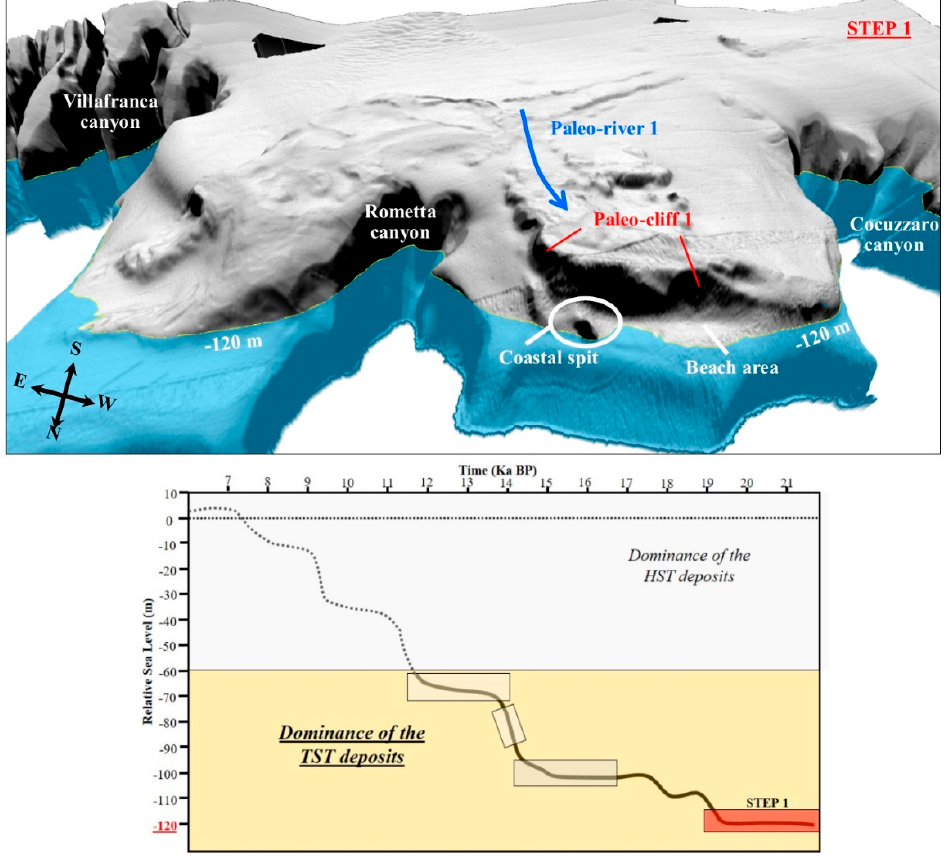
Figure 7. On the basis of a 3D bathymetric map, the reconstruction of the geomorphological evolution of past coastal systems of the area between the Cocuzzaro and Rometta canyons, of past coastal systems of the area between the Cocuzzaro and Rometta canyons, simulating a sea simulating a sea level of − 120 m. level of − 120